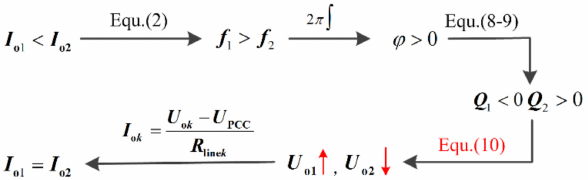
Figure 4. Reactive power-voltage feedback control process